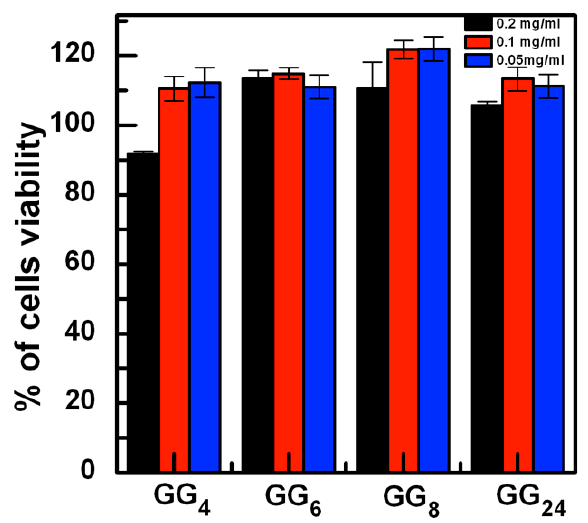
Figure 9. Viability of MC3T3-E1 preosteoblastic cells cultured for 24 h in the presence of GG degradation products at different concentrations. Viability is expressed as % compared to untreated cells.